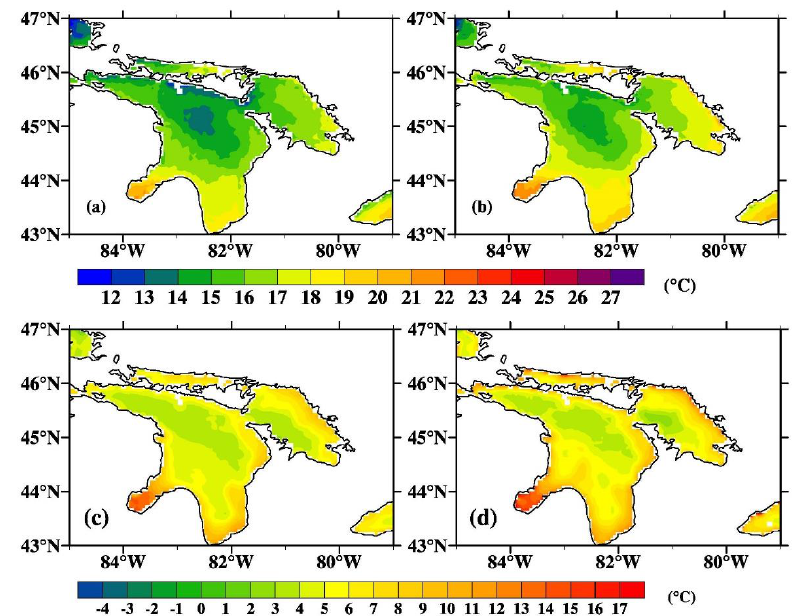
Figure 6. Upper : LST retrievals for July from MOD11C1 (Terra) observations averaged during 2004–2009 for: ( a ) Nighttime; ( b ) Daytime. Lower: same as above for a particular day (28 May 2008); ( c ) nighttime; ( d ) daytime In Figure 7, we show the Mean Minimum/Maximum and DTR spatial variability as seen from GOES ˗ E and Mean Night/Day and DTR from MOD11 LST averaged for 2004–